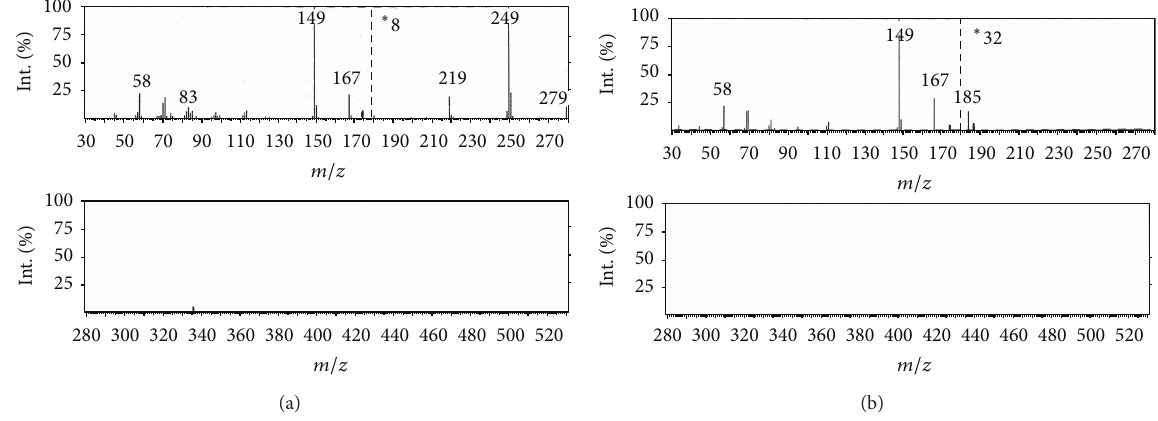
Figure 3: MS graphs of the extracted dye: (a) 𝑛 -hexane/petroleum ether (90:10, v/v), 𝑅 𝑓 = 0.32 and (b) petroleum ether/diethyl ether (50:50, v/v), 𝑅 𝑓 = 0.68 .